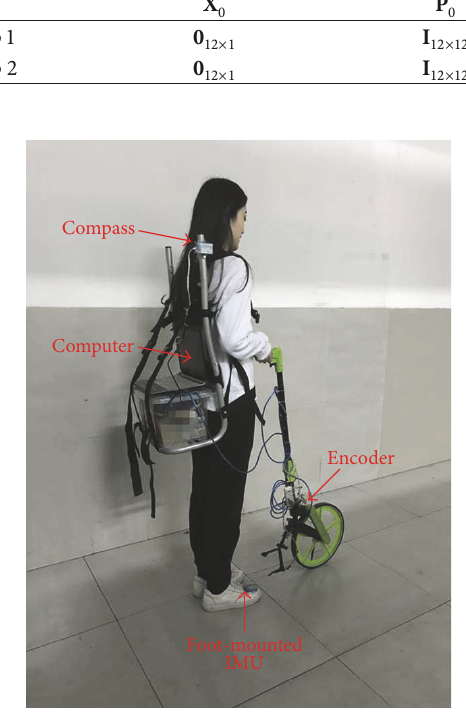
Figure 2: The prototype of the test platform.